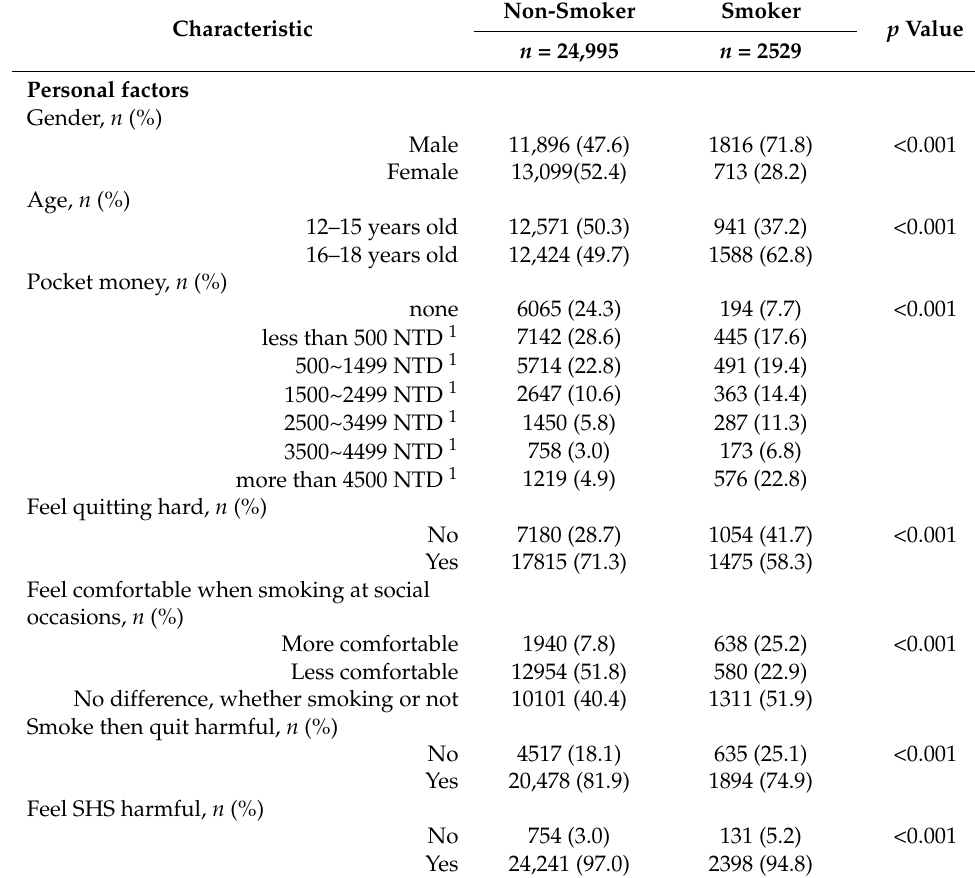
Table 1. Characteristics of non-smokers and smokers ( n =